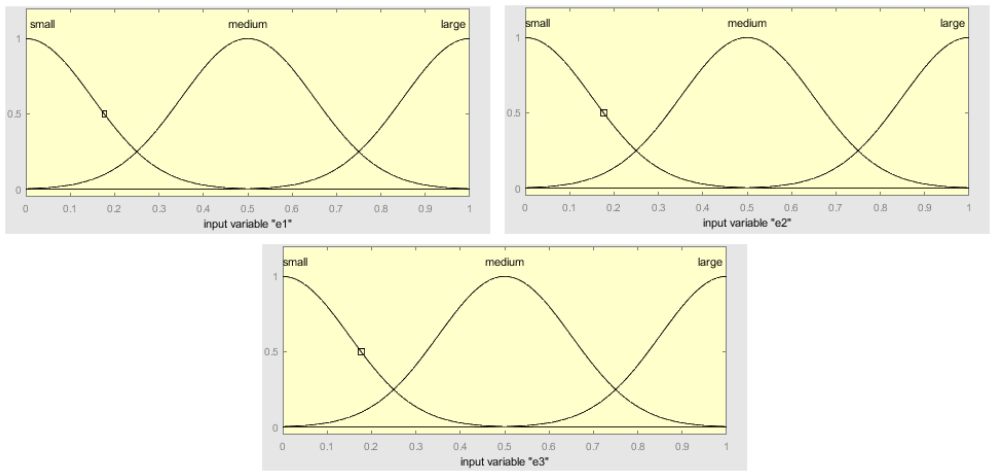
Figure 5. The fuzzy input membership functions of 𝑒 1 , 𝑒 2 , and 𝑒 3 with Gaussian functions.